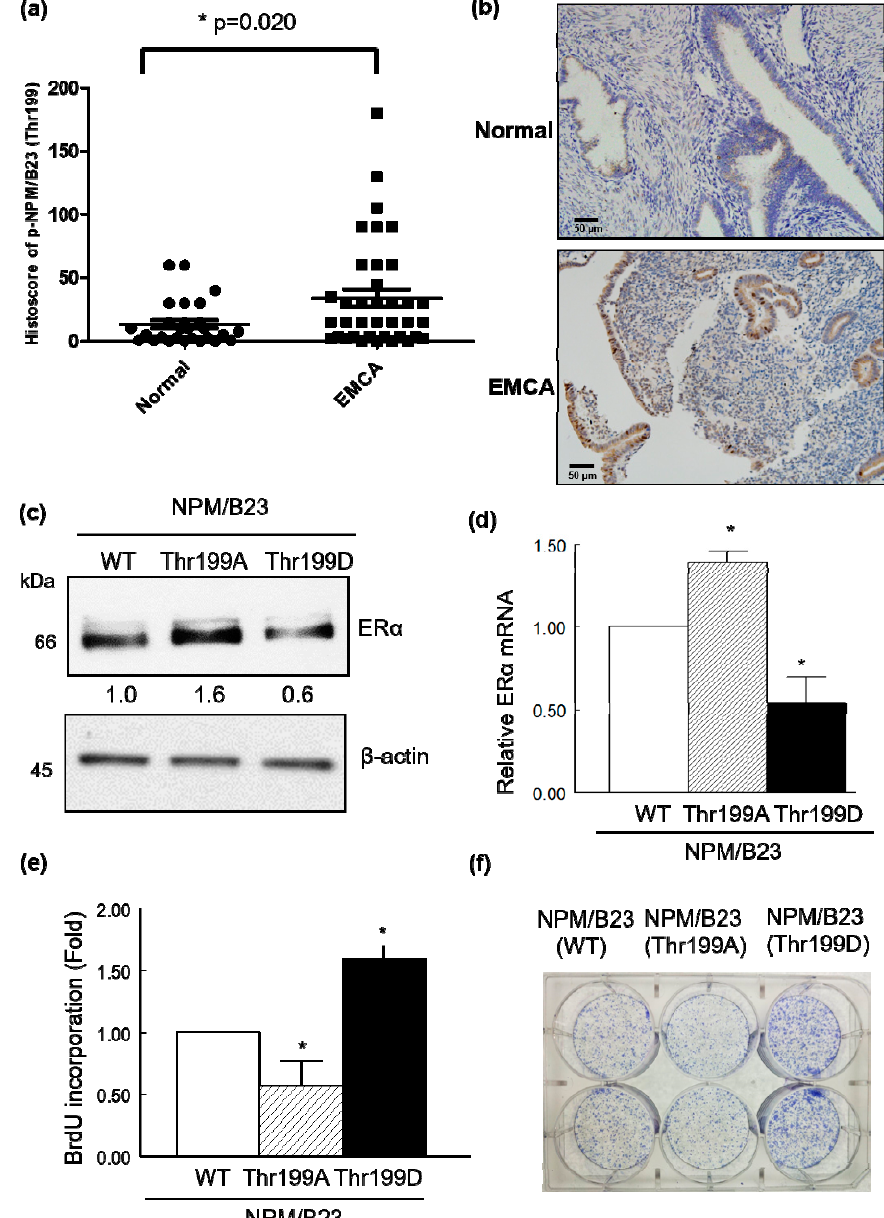
Figure 3. Role of phospho-NPM / B23 (Thr199) expression in endometrial tumorigenesis. ( a ) The immunohistochemical expression of phospho-NPM / B23 (Thr199) was analyzed in both normal endometrial tissues obtained from patients who underwent hysterectomy for benign gynecologic conditions ( n = 27) and endometrial cancer ( n = 37; Supplementary Table S1). ( b ) Representative immunohistochemical staining of phospho-NPM / B23 (Thr199) in benign endometrial tissue (upper panel) and endometrial cancer (EMCA; lower panel). Magnification: 100 × ; scale bar: 50 µ m. ( c ) ER α -positive HEC1B cells were transfected with NPM / B23 (WT), the dephospho-mimetic NPM / B23 mutant (Thr199A), or the phospho-mimetic NPM / B23 mutant (Thr199D) for 24 h. Cell lysates were resolved on SDS-PAGE and subjected to immunoblotting with antibodies raised against ER α and β -actin. Densitometry-derived values (bottom) are normalized with the NPM / B23 (WT), which was set as 1. Data shown are derived from three independent experiments. β -actin serves as the loading control